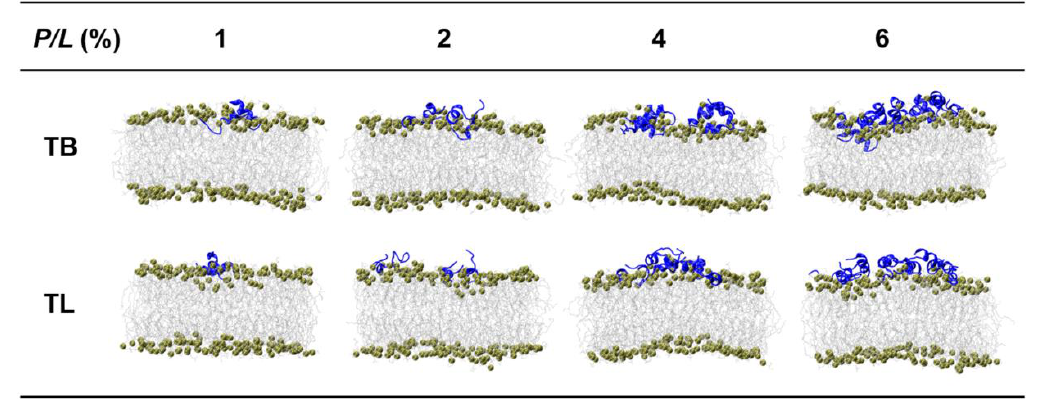
Figure 2. Snapshots of TBs and TLs at different peptide concentrations interacting with membrane. Blue ribbons represent peptides, tan beads represent phosphorous atoms, silver chains represent alkyl tails of lipid.